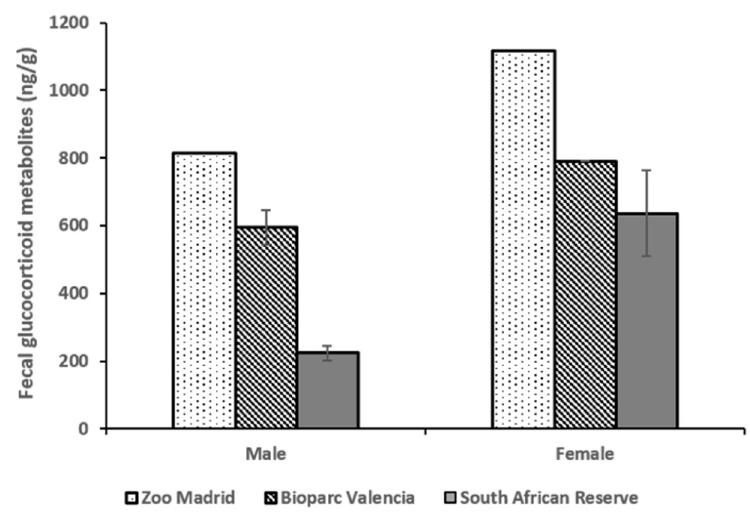
Figure 6. Fecal glucocorticoid metabolite concentrations (fGCM) ± standard error of the mean (S.E.M.) between the different sexes in the three groups.